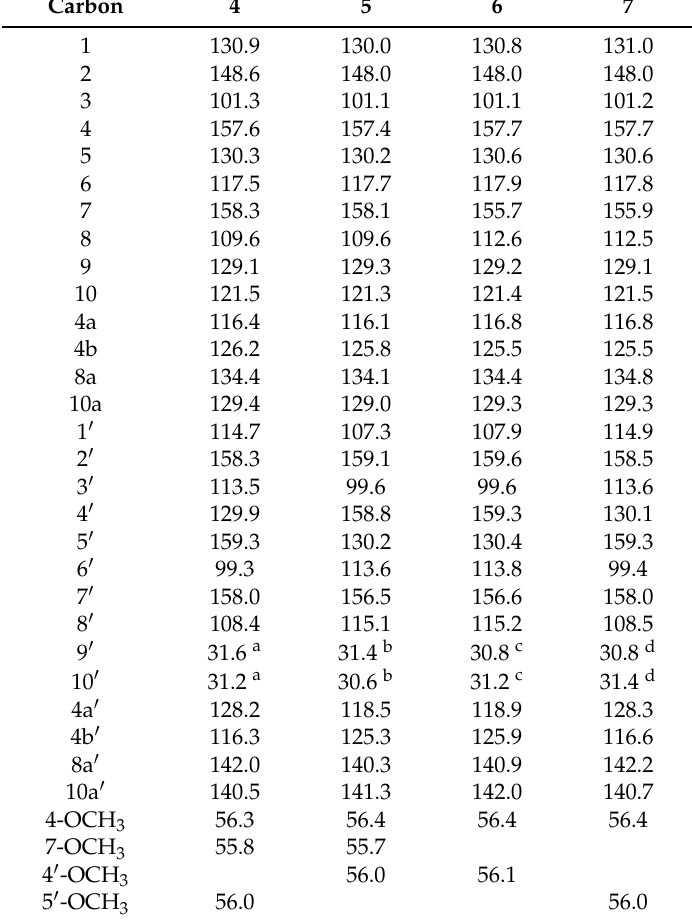
Table 4. 13 C-NMR Data of compounds 4 – 7